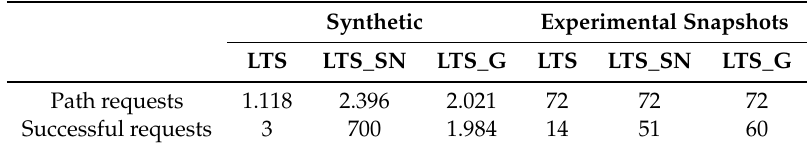
Table 3. The amount of path generation attempts and the amount that succeeded, for each version, in each